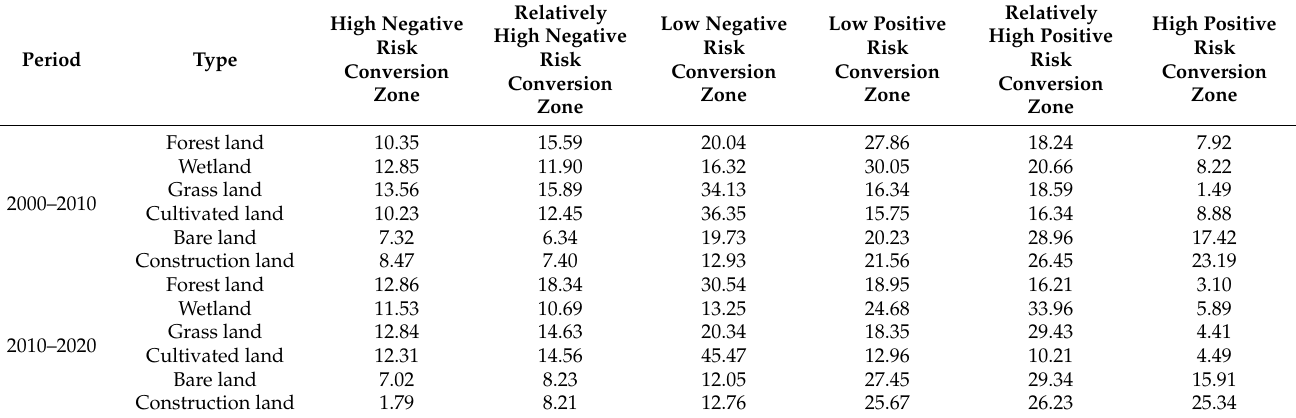
Table 4. Proportion of LER transfer area of different types in typical areas of the Yellow River Basin from 2000 to 2020.